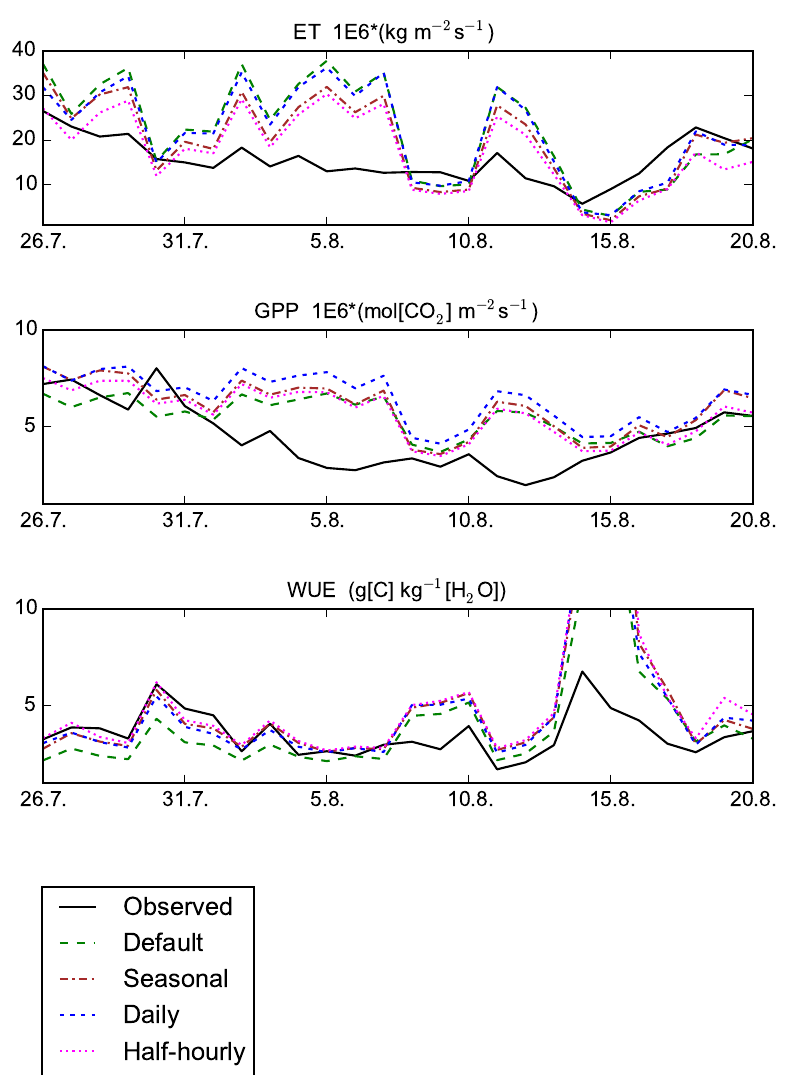
Figure 5. Daily averages for ET, GPP and WUE on a dry event in 2006 for Hyytiälä.